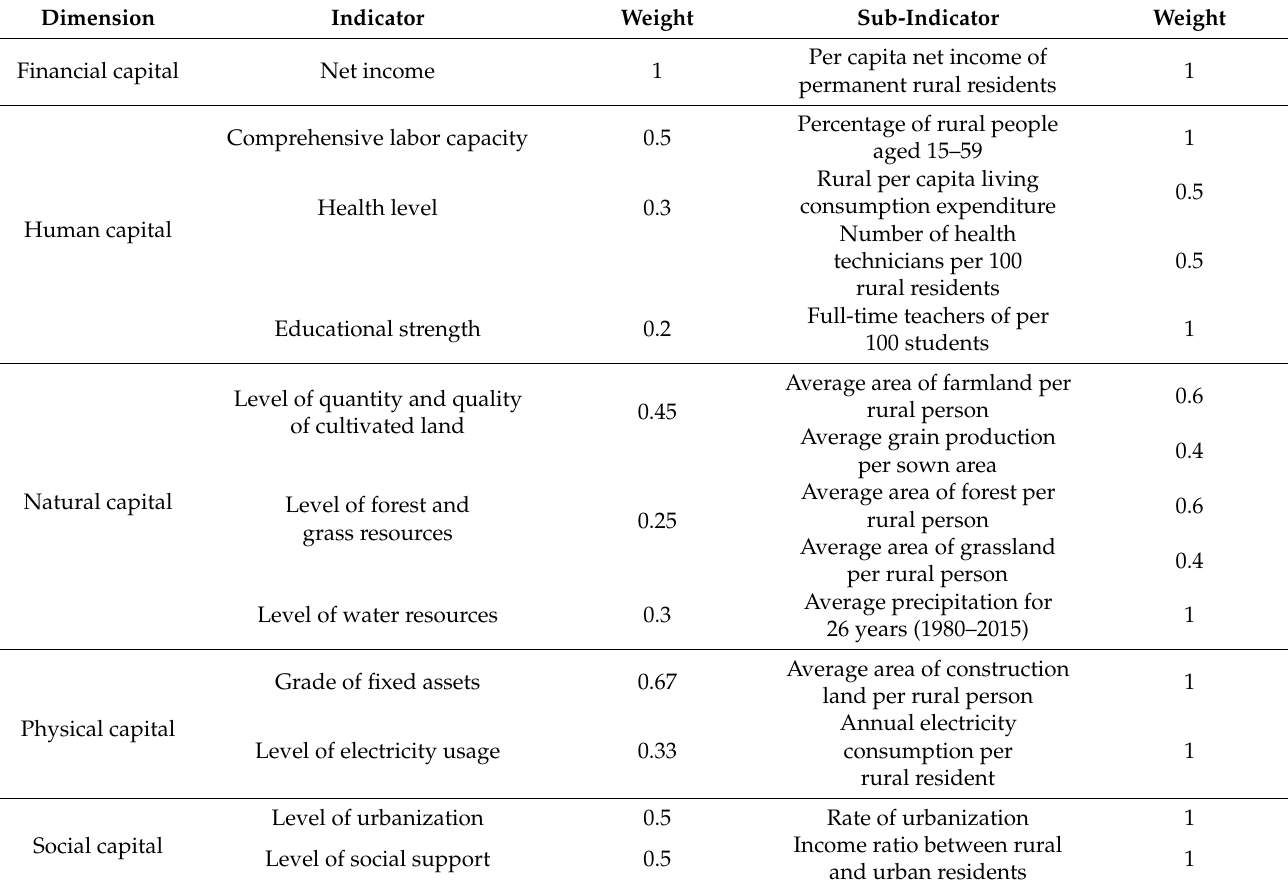
Table 5. Indicator system and weights for multidimensional poverty at the county